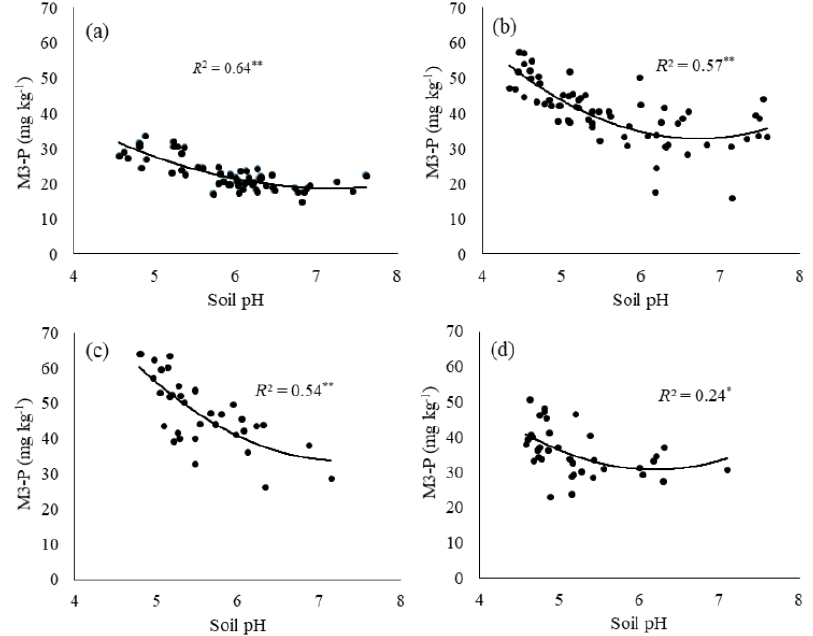
Figure 2. Relationship between soil pH and Mehlich ‐ 3 phosphorus (M3 ‐ P) for each location: ( a ) Chickasha, ( b ) Efaw, ( c ) Lahoma, and ( d ) Perkins. Total soil P was constant within each location. **, *: indicates significance at p < 0.01 and 0.05, respectively, for the second ‐ order linear regression model. ns: not significant.